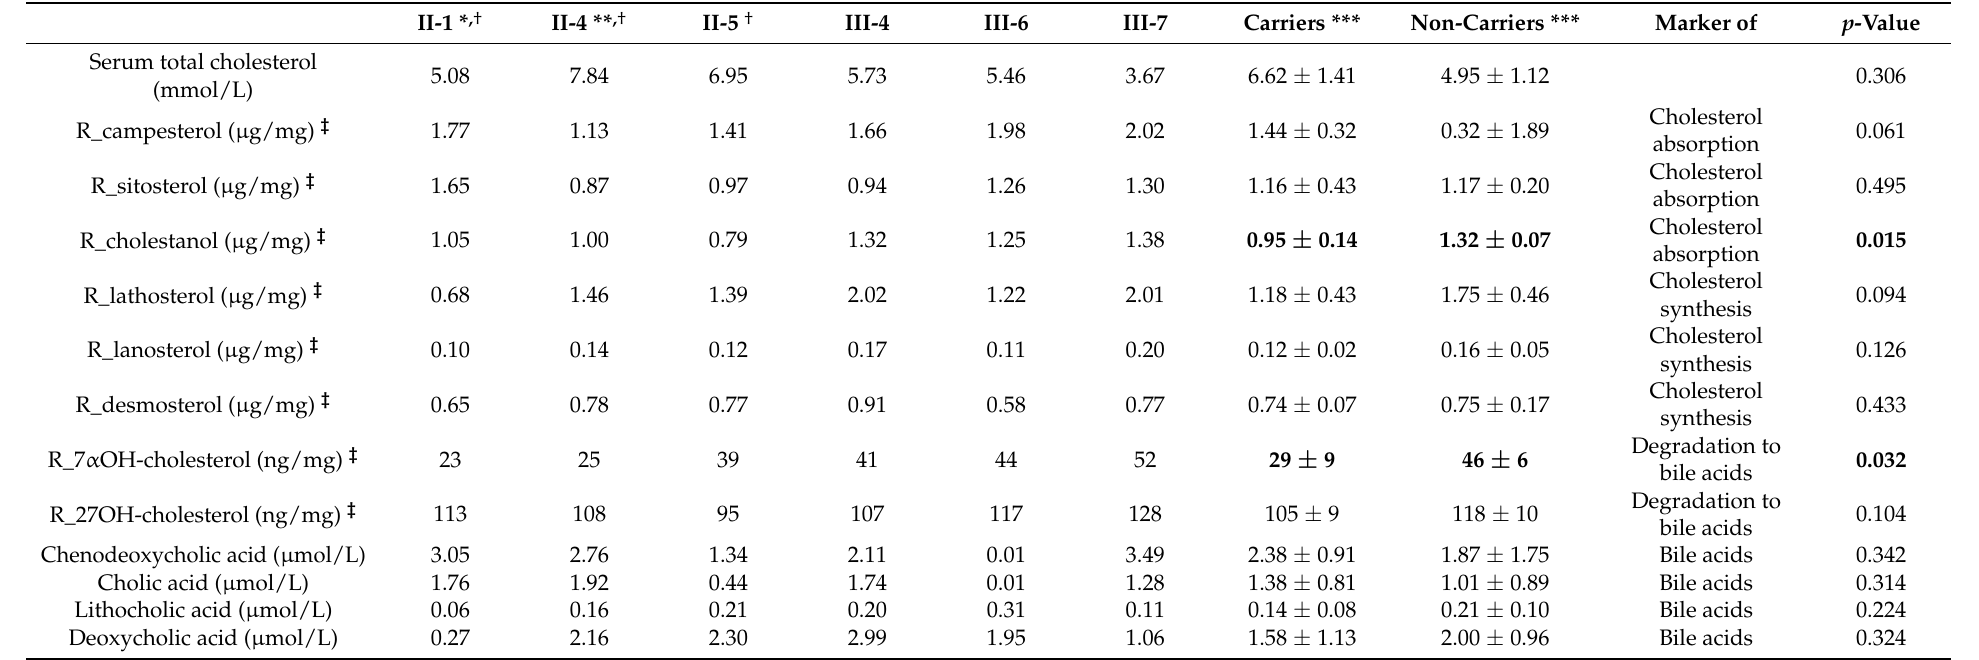
Table 3. Sterol and bile acid measurements in family